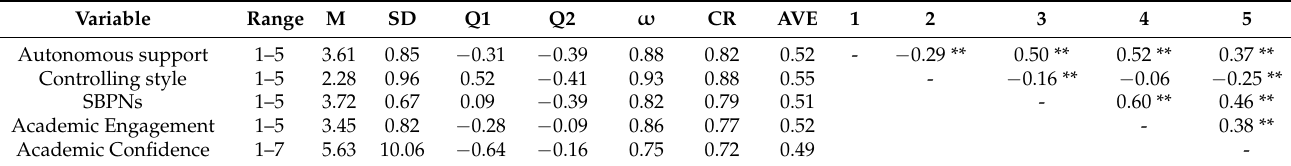
Table 1. Descriptive statistics and correlations between